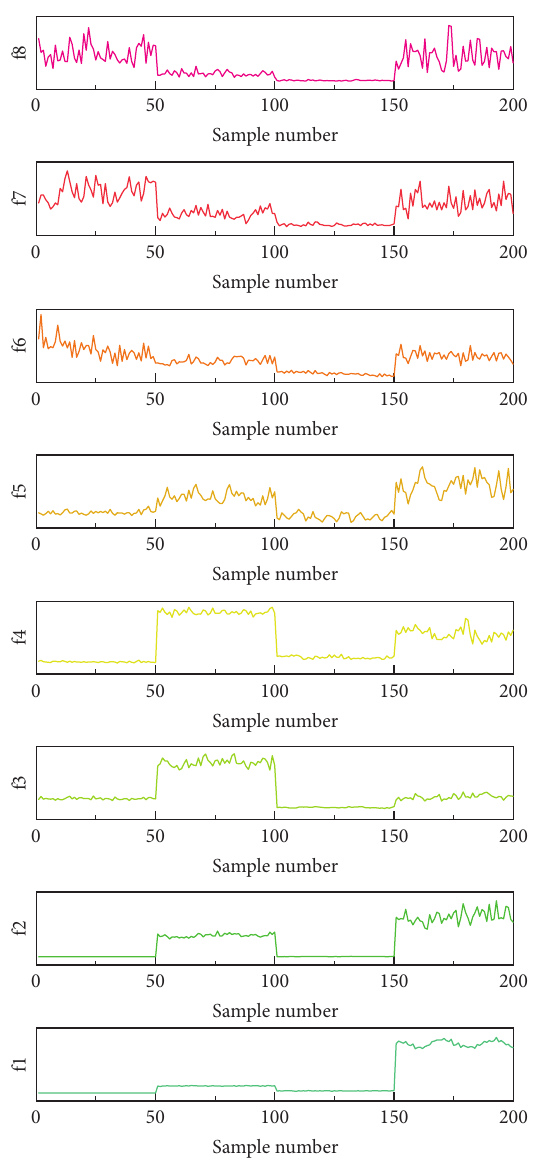
Figure 1: Data feature sets.